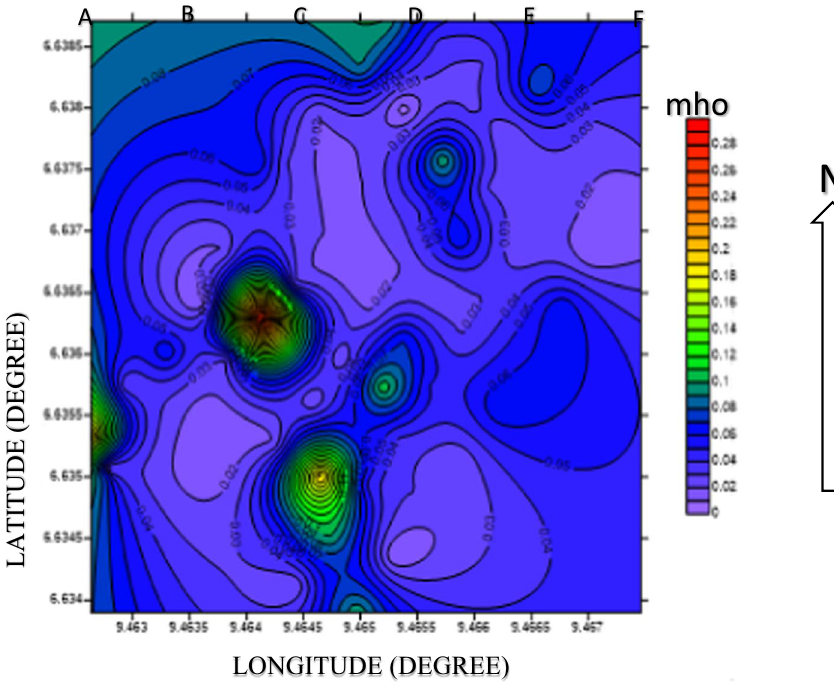
Fig. 10 Contour map of the longitudinal conductance distri- bution in the area